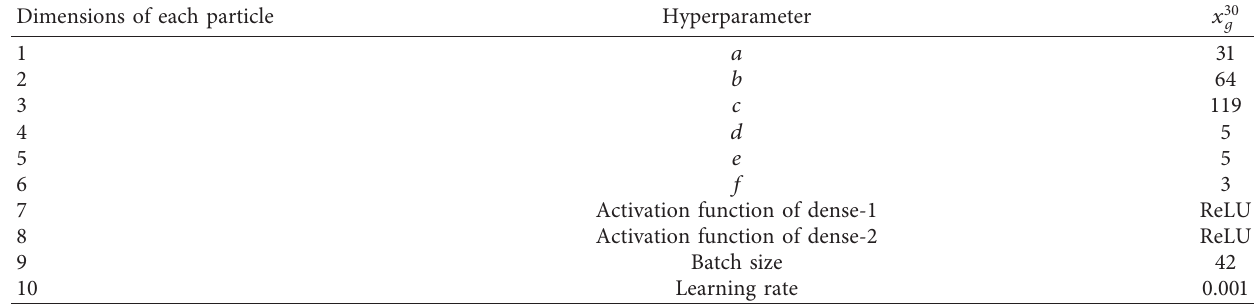
Table 3: Optimal hyperparameters setting.